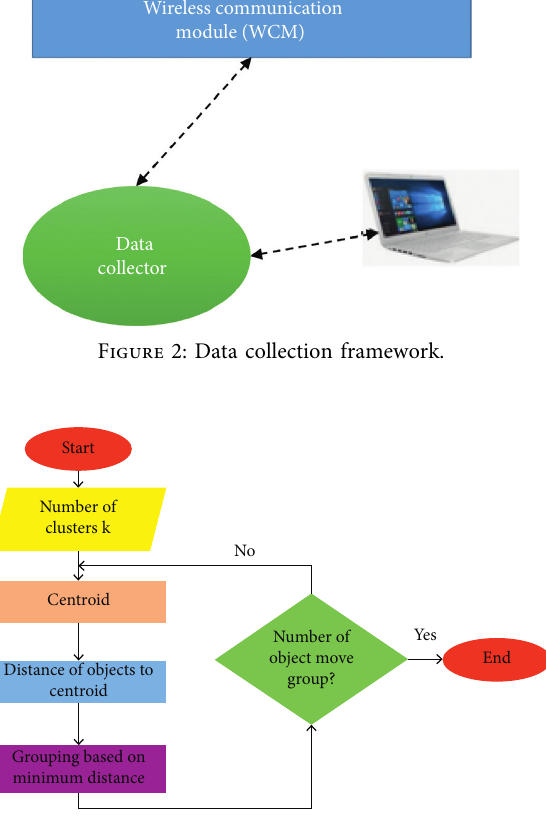
Figure 3: K-means clustering algorithm. Table 1: Total loads in the microgrid with their classifications.